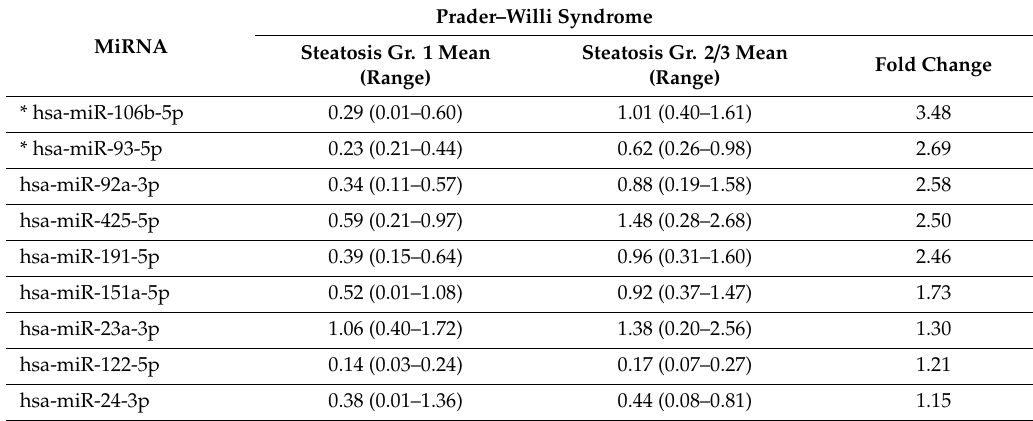
Table 3. Relative mean ∆∆ Cq expression of serum miRNAs in PWS + Grade 1 and PWS + grade 2 / 3.